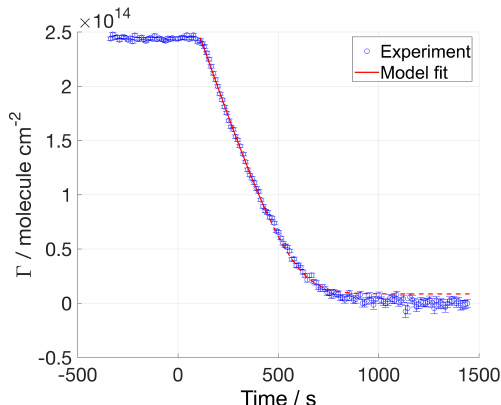
Figure 9. Methyl oleate ( d 33 MO) exposed to [NO 3 ] = 36ppt. The red line illustrates the fit obtained from our kinetic modelling (the solid section of the line indicates the data range used for the kinetic analysis; the dashed section of the model line illustrates the calcu- lated final part of the decay, but the corresponding experimental data were not used in the optimisation of the